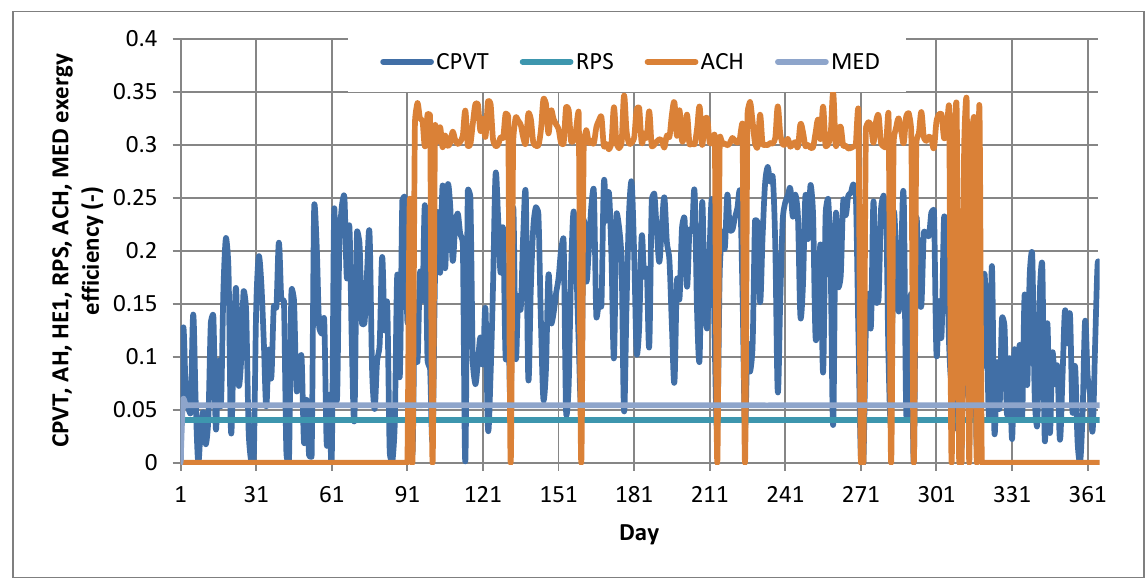
Figure 6. Daily exergy